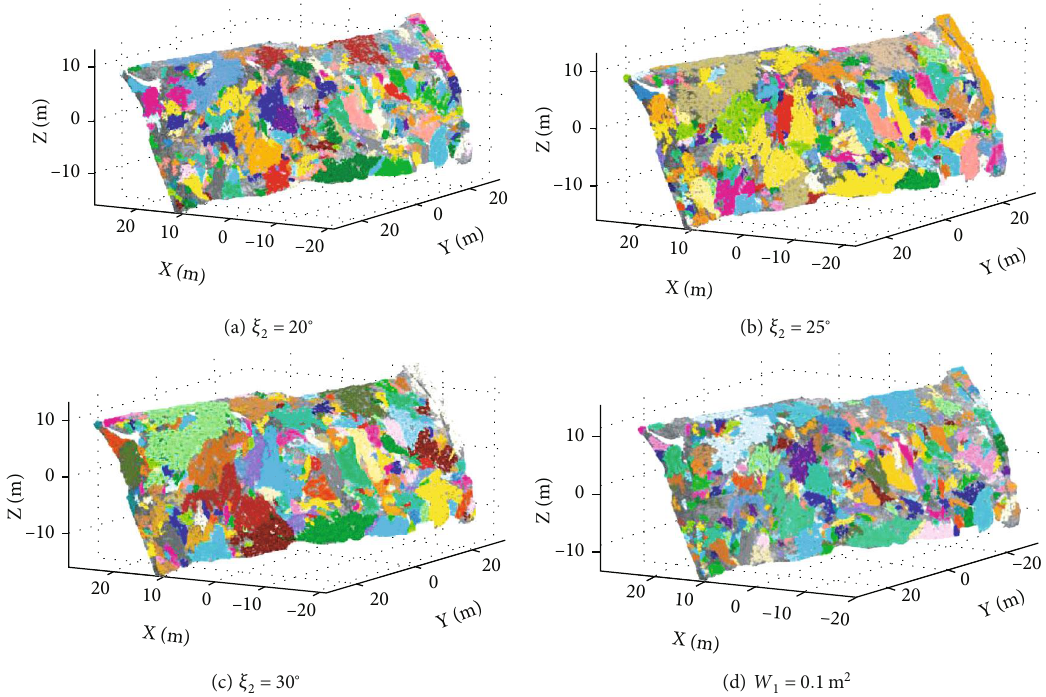
Figure 5: Intelligent identi fi cation results of rock structural plane under di ff erent growth and area